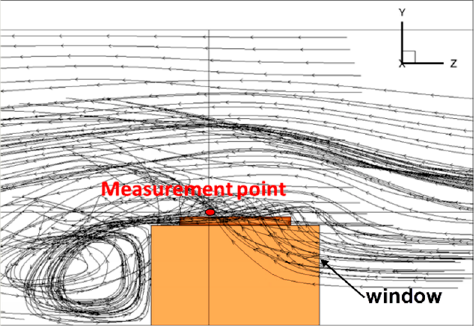
Figure 8. Measurement point and recirculations.